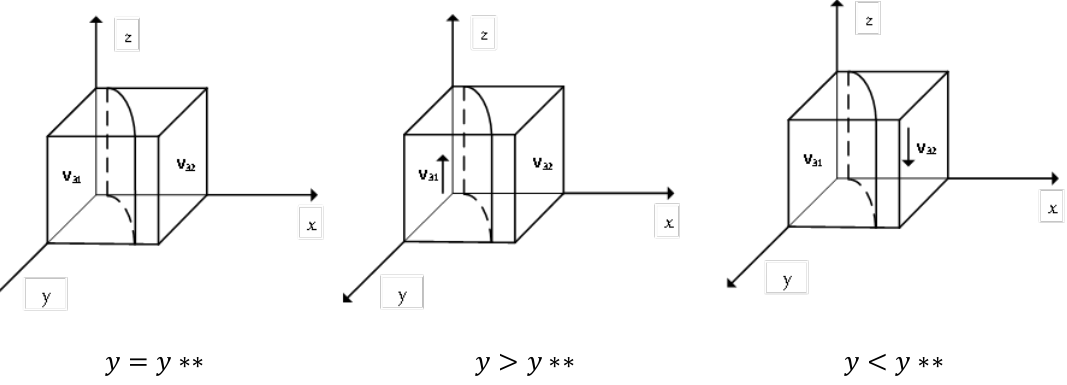
Figure 3. Evolutionary phase diagram of the government stabilization strategies.